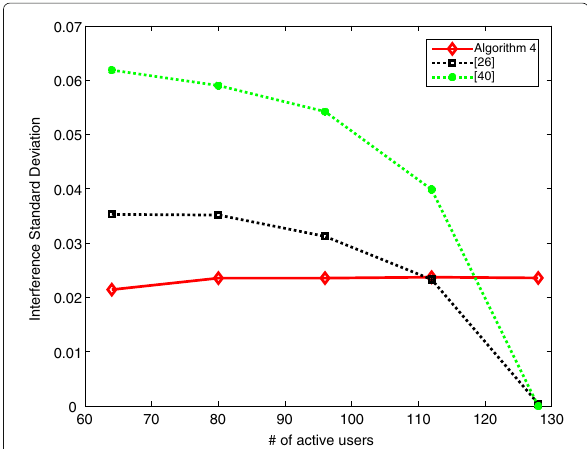
Fig. 5 Standard deviation of the interference term for variable number of active users in a s-CDMA system designed for 128